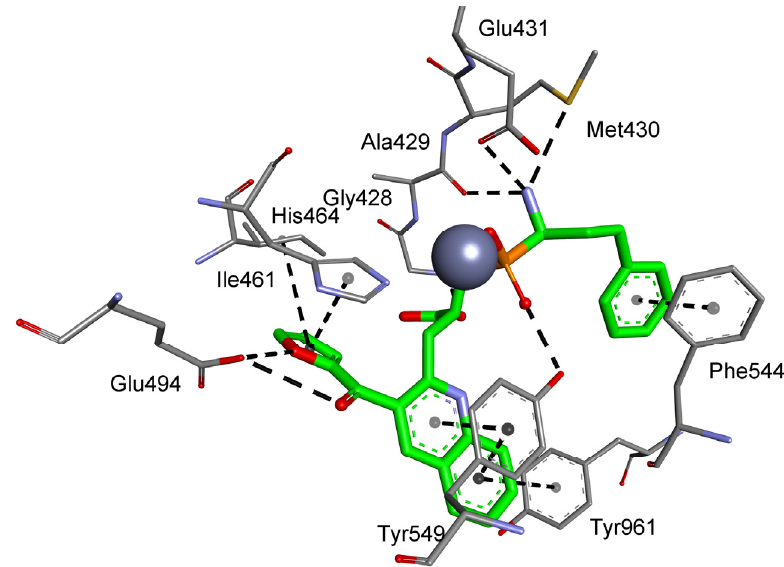
Figure 4. Modeled binding mode of a phosphinic dipeptide analog containing a 3-(furan-2-carbonyl)quinolin-2-yl P1 ′ fragment in the active center of cystinyl aminopeptidase (PDB: 5MJ6).